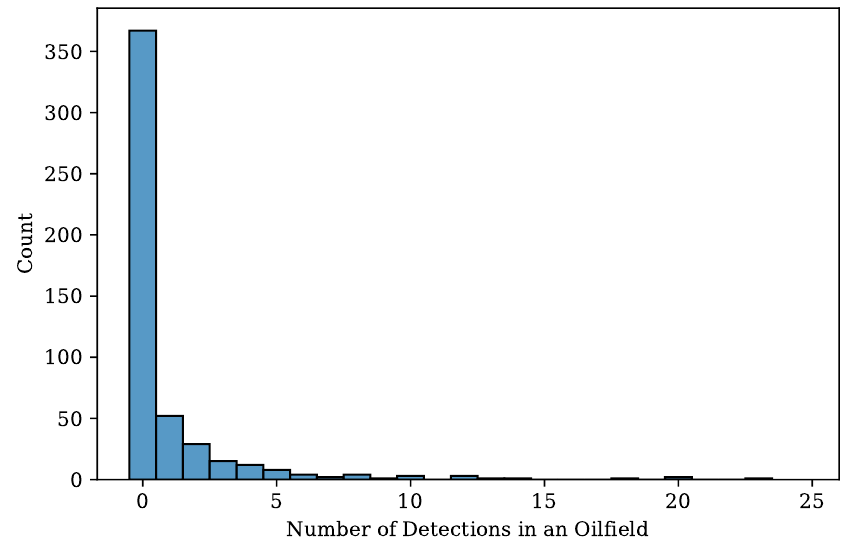
Figure 15. A histogram for the distribution of the field detection counts from October 2018. There are plenty of zeros (more than 350) and a few fields have comparatively large detection counts (greater than 20).